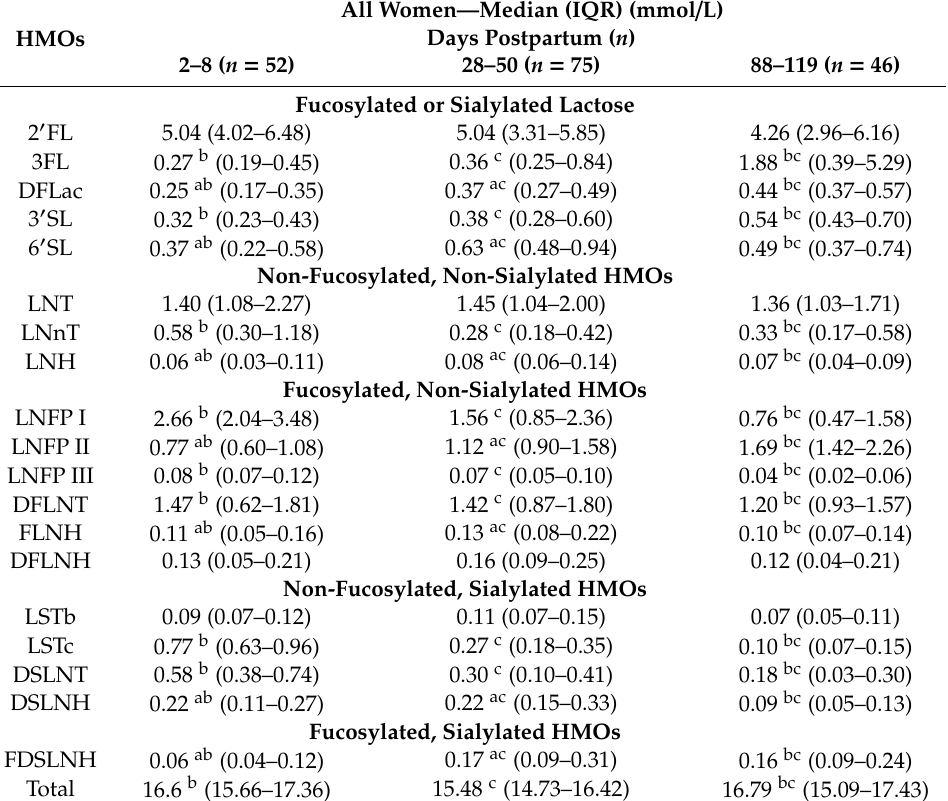
Table 2. Time variation of human milk oligosaccharides (HMOs) concentrations in all women in the Brazilian cohort. Rio de Janeiro, Brazil ( n =